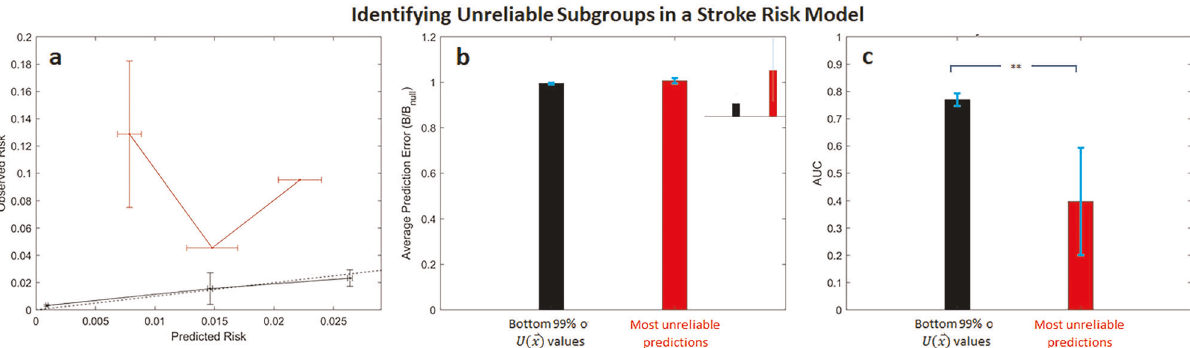
Fig. 5 Unreliable predictions in the Stroke risk model. a Calibration curves, b normalized Brier scores (inset shows expanded region corresponding to 0 : 95 (cid:2) Brier = Brier null (cid:2) 1 : 02 ), and c AUCs for the most untrustworthy predictions (red) and those that fall within the bottom * Þ 99% U ð x values (black). ** p « 0.0001. Error bars are from 100 bootstrap splits and show one standard deviation ( a ) or one standard error of the mean ( b and c